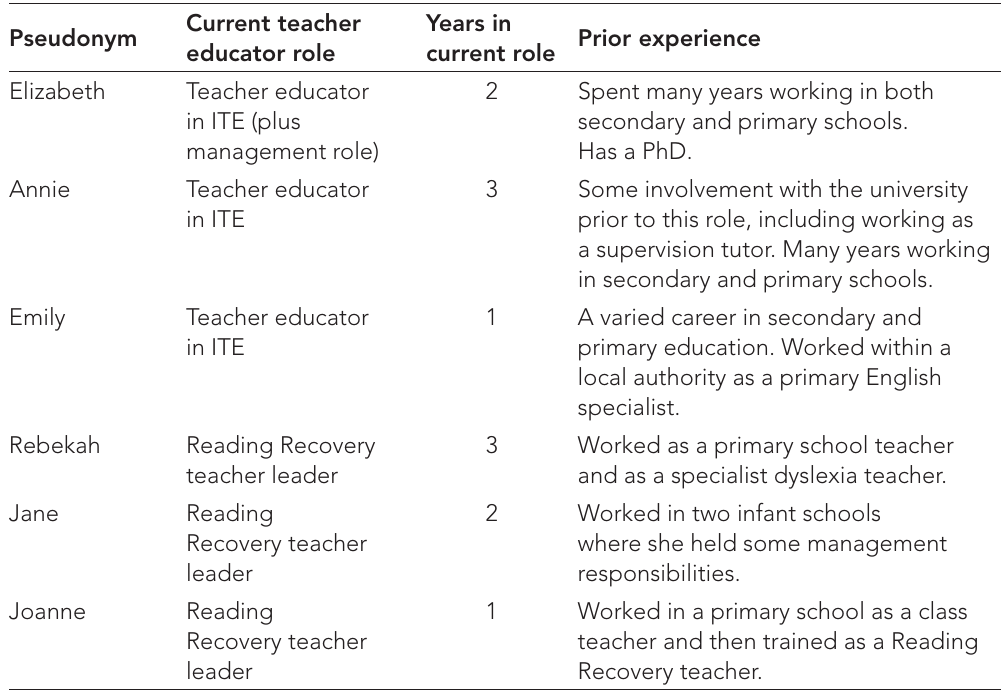
Table 1: The participants in the study (Source: Author,